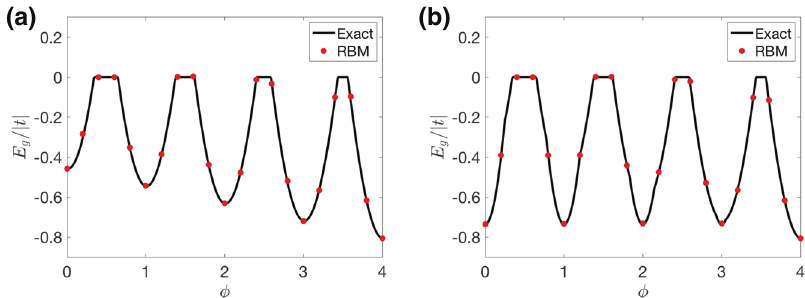
Fig. 4 Numerical results for triple quantum dots. The ground state energy of a lateral TQD ( N = M = 6) as a function of magnetic fi eld obtained from the NQS-ITE algorithm (solid red dots) and the exact diagonalization (solid black lines). Panel a U i = 50 ∣ t ∣ , V ij = 10 ∣ t ∣ and E i = t , and b U i = 0.5 ∣ t ∣ , V ij = 0.1 ∣ t ∣ , and E i = t .